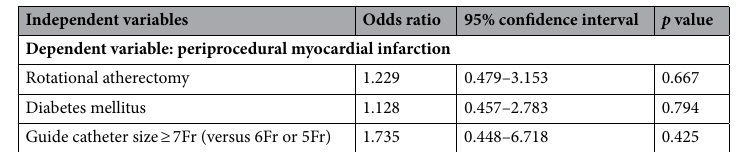
Table 3. Multivariate logistic regression model to find the factors associated with periprocedural myocardial infarction in the matched RA and non-RA groups. In the multivariate logistic regression model, the selection of independent variables was derived from the results of matched groups; rotational atherectomy, diabetes mellitus and Guide catheter size.” Although the use of orbital atherectomy was significantly different between the matched group, there was no periprocedural myocardial infarction in lesions required orbital atherectomy, which makes impossible to calculate a odds ratio. Therefore, orbital atherectomy was not included in the